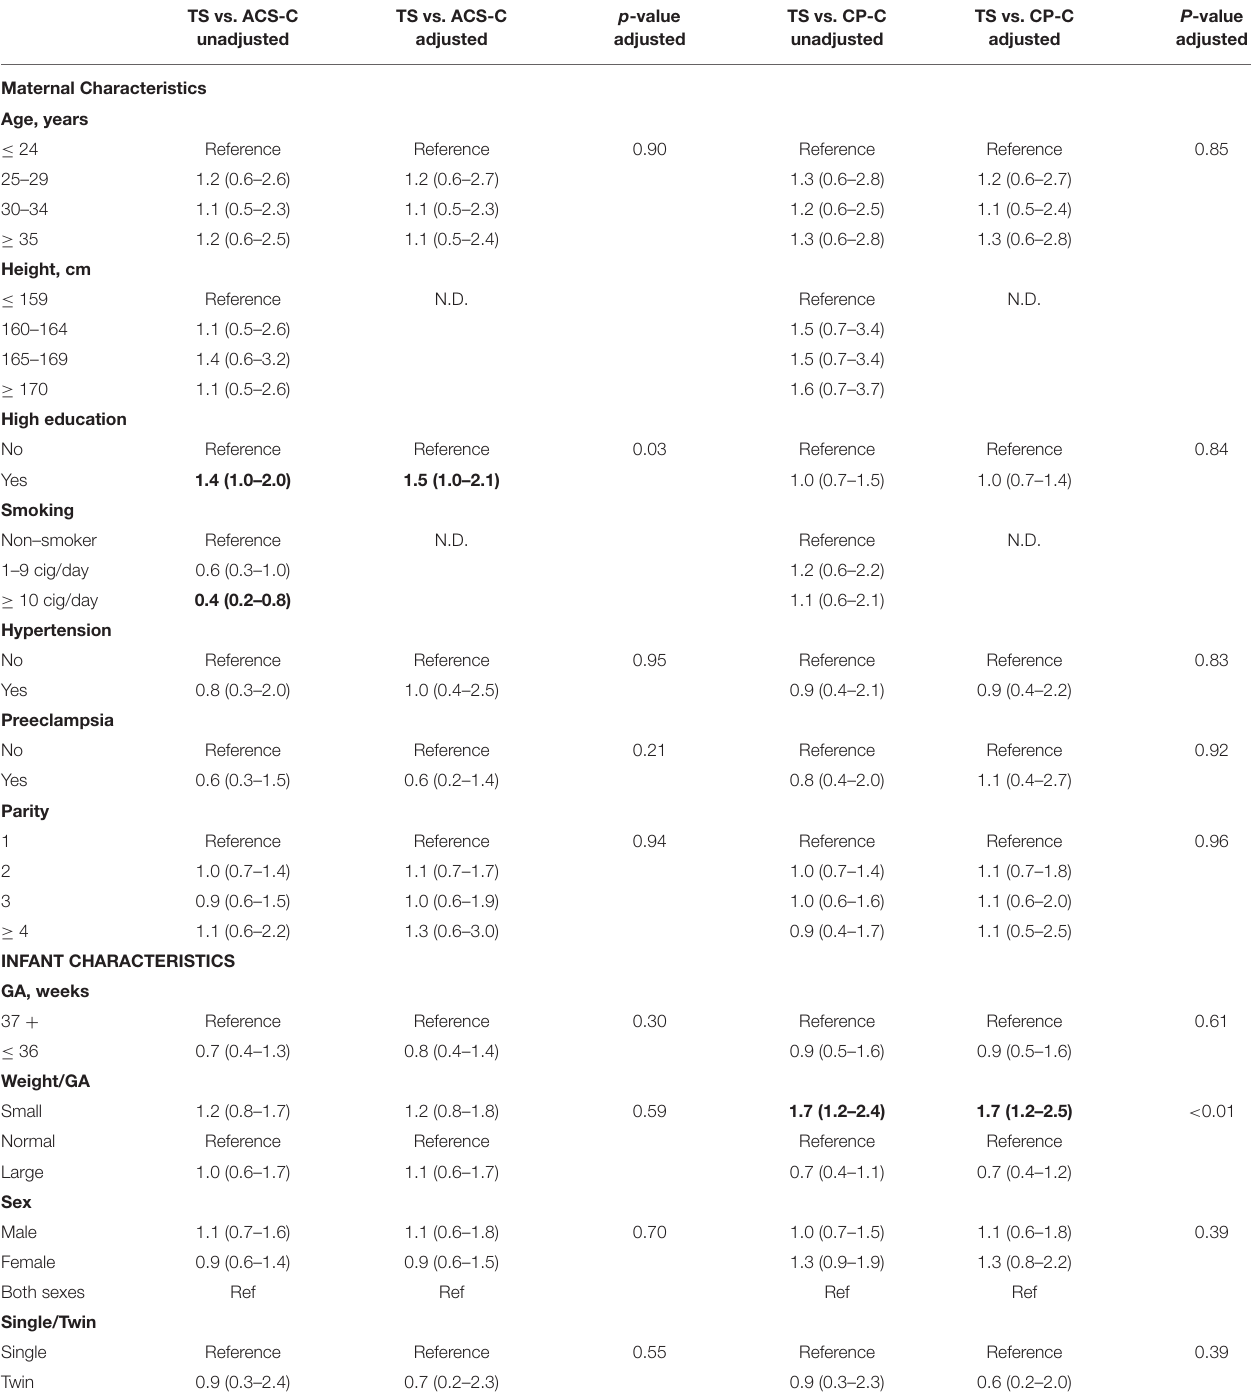
TABLE 2 | Maternal and infant characteristics comparisons between takotsubo syndrome and the two control groups.